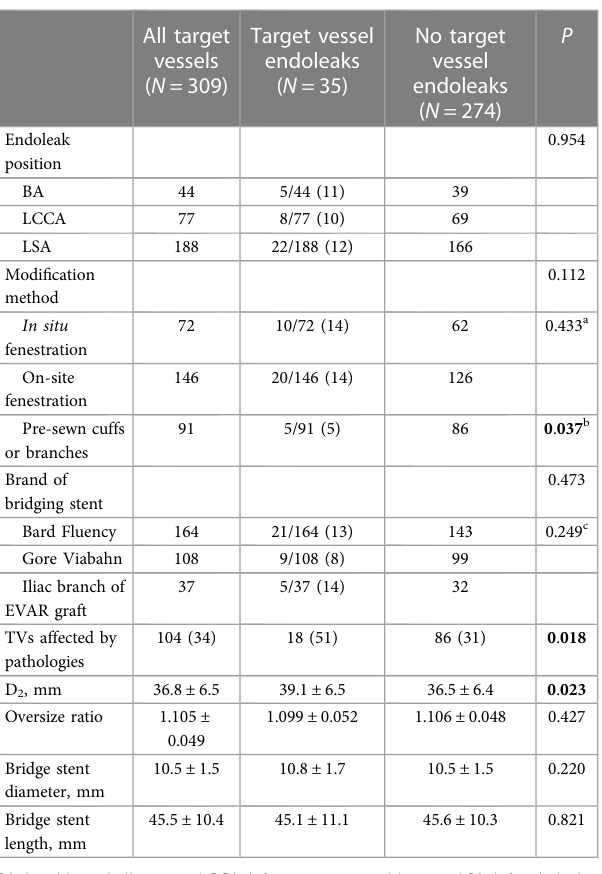
TABLE 3 Potential in fl uencing factors for target vessel-related endoleaks among 309 target vessels after fb-arch repair.